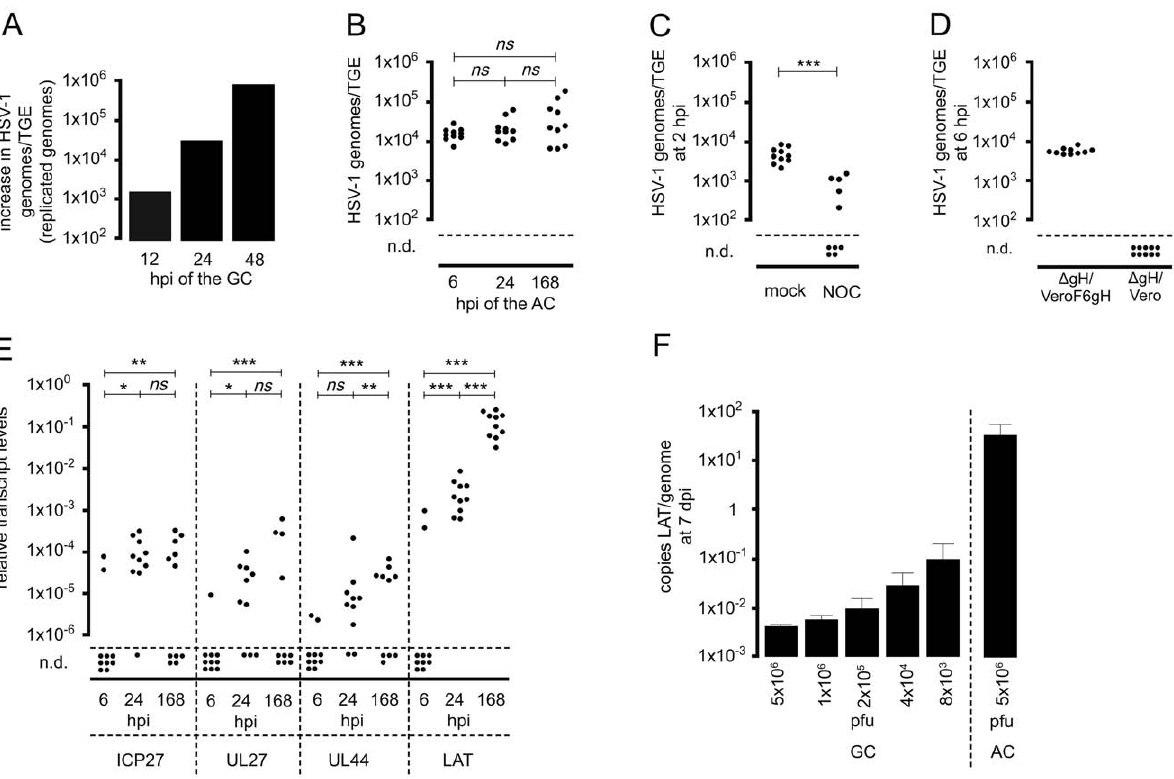
Figure 3. Genome and transcript levels in HSV-1-infected TGEs. (A) Replication of HSV-1 17syn + in TGEs infected in the GC. Groups of three TGEs were infected in the GC with 1 6 10 4 pfu of HSV-1 17syn + . TGEs were harvested at the time points indicated. DNA extracts were pooled, genome levels per TGE were quantified by qPCR, and the increase in genome levels relative to that at 1 hpi was determined (replicated genomes). (B) Genome levels in TGEs infected in the AC with HSV-1 17syn + . Groups of ten cultures, each containing two TGEs, were infected with 5 6 10 6 pfu of HSV-1 17syn + , TGEs of individual cultures were pooled and genome levels/TGE were determined by qPCR at the time points indicated, n.d., No viral genomes detected by qPCR. The statistical significances of results are indicated as follows: ns (not significant), P . 0.05; * P =0.005–0.05; ** P =0.0005–0.005; *** P , 0.0005. The median genome levels did not differ significantly between 6 hpi and 24 hpi, 24 hpi and 7 dpi, and 6 hpi and 7 dpi ( P =0.393, 0.4813, and 0.2176, respectively; Mann-Whitney test). (C) Effect of nocodazole on the axonal transport of viral particles. Cultures were infected in the AC with 5 6 10 6 pfu of HSV-1 17syn + in the presence of 10 m M nocodazole (NOC); mock-treated cultures served as controls. TGEs were harvested at 2 hpi, and genome levels were determined by qPCR, n.d., No viral genomes detected by qPCR. Differences in genome levels between NOC-treated and untreated cultures at 2 hpi were highly significant ( P =0.0002; unpaired t test with Welch correction). (D) Infection of the AC with the fusion-deficient, gH-negative mutant HSV-1 KOSgH87. Infection of the AC was performed with 1 6 10 8 particles of HSV-1 KOSgH87. The virus was purified using a saccharose gradient from the supernatants of transcomplementing VeroF6gH cells ( D gH/VeroF6gH) (corresponding to 5 6 10 6 pfu on VeroF6gH cells) and of noncomplementing Vero cells ( D gH/Vero) (corresponding to 10 pfu on VeroF6gH cells). Genome levels were determined by qPCR at 6 hpi. (E) Transcript levels in TGEs axonally-infected with HSV-1 17syn + . Groups of ten cultures, each containing two TGEs, were infected in the AC with 5 6 10 6 pfu. IE (ICP27), E/L (UL27), L (UL44), and LAT transcripts were quantified by RT-PCR and normalized to b -actin transcript levels. Transcript levels at 6, 24, and 168 hpi (7 dpi) are shown, n.d., No viral transcripts detected. The statistical significances of differences in median transcript levels between 6 and 24 hpi, 24 and 168 hpi, and 6 and 168 hpi are indicated (ICP27: P =0.0068, 0.8798, and 0.0011, respectively; UL27: P =0.0433, 0.1124, and 0.0001, respectively; UL44: P =0.1230, 0.0021, and , 0.0001, respectively; LAT: P , 0.0001, , 0.0001, and , 0.0001, respectively; Mann-Whitney test). (F) Specific transcriptional activity of the LAT gene in TGEs infected in the GC and AC, respectively. Groups of four TGEs were infected in the GC with different infectious doses of HSV-1 17syn + as indicated. A group of ten TGEs was infected in the AC with 5 6 10 6 pfu. At 7 dpi, LAT copies and viral genomes/TGE were quantitated by qPCR, and the mean ratio of LAT copies/HSV-1 genomes was determined. Data are mean and SD